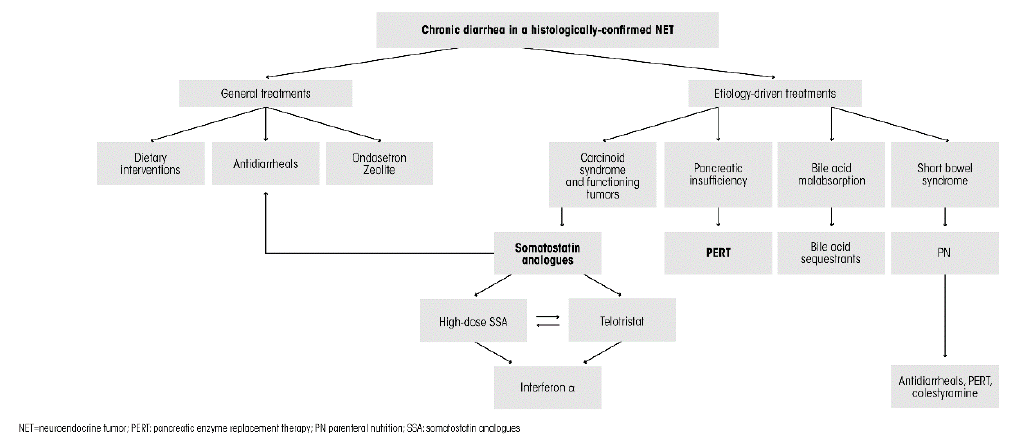
Figure 2. Algorithm for the treatment of diarrhea in NET patients, as applied in the authors’ institution.